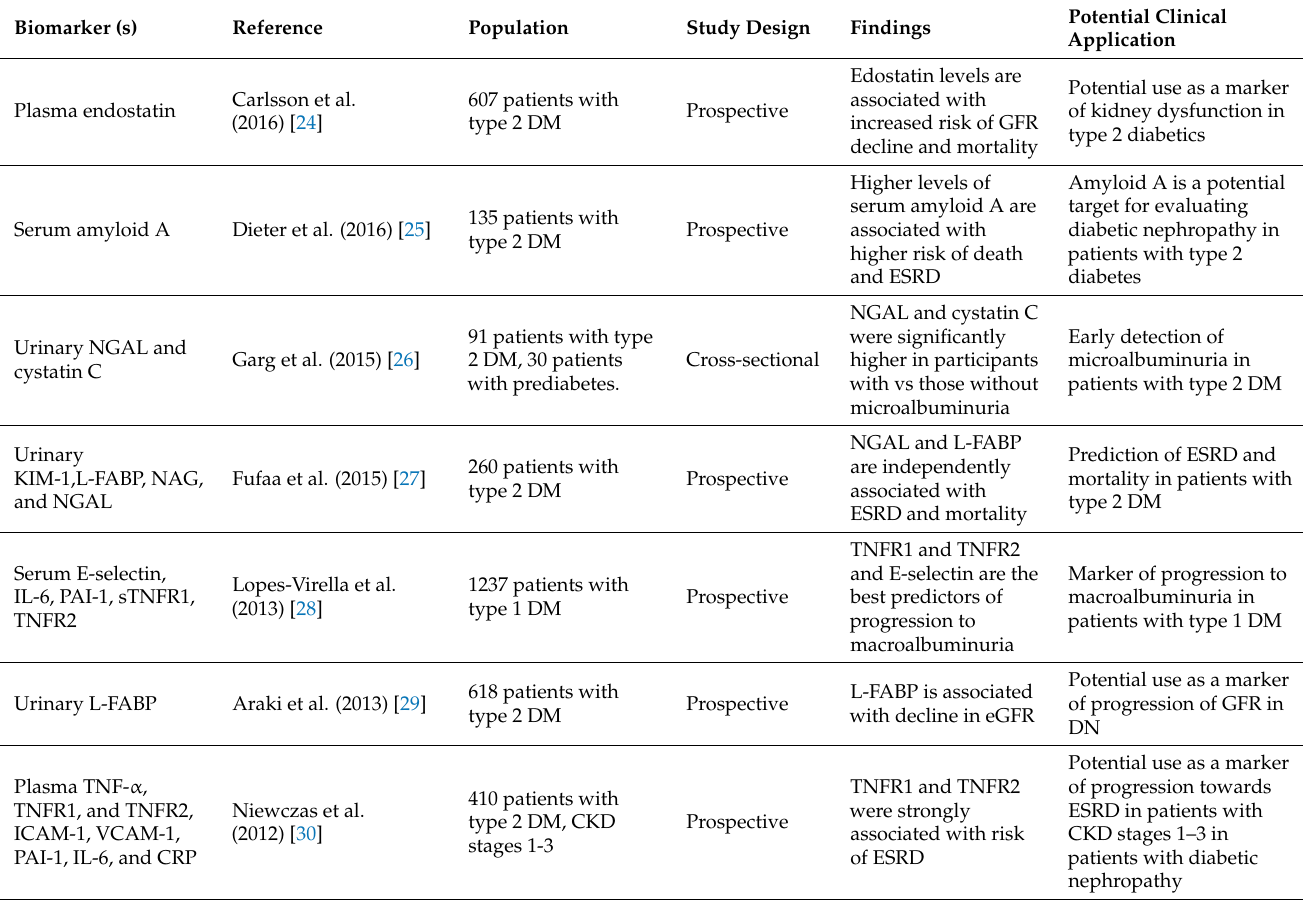
Table 2. Clinical trials evaluating biomarkers and their main findings, with potential clinical correla- tions